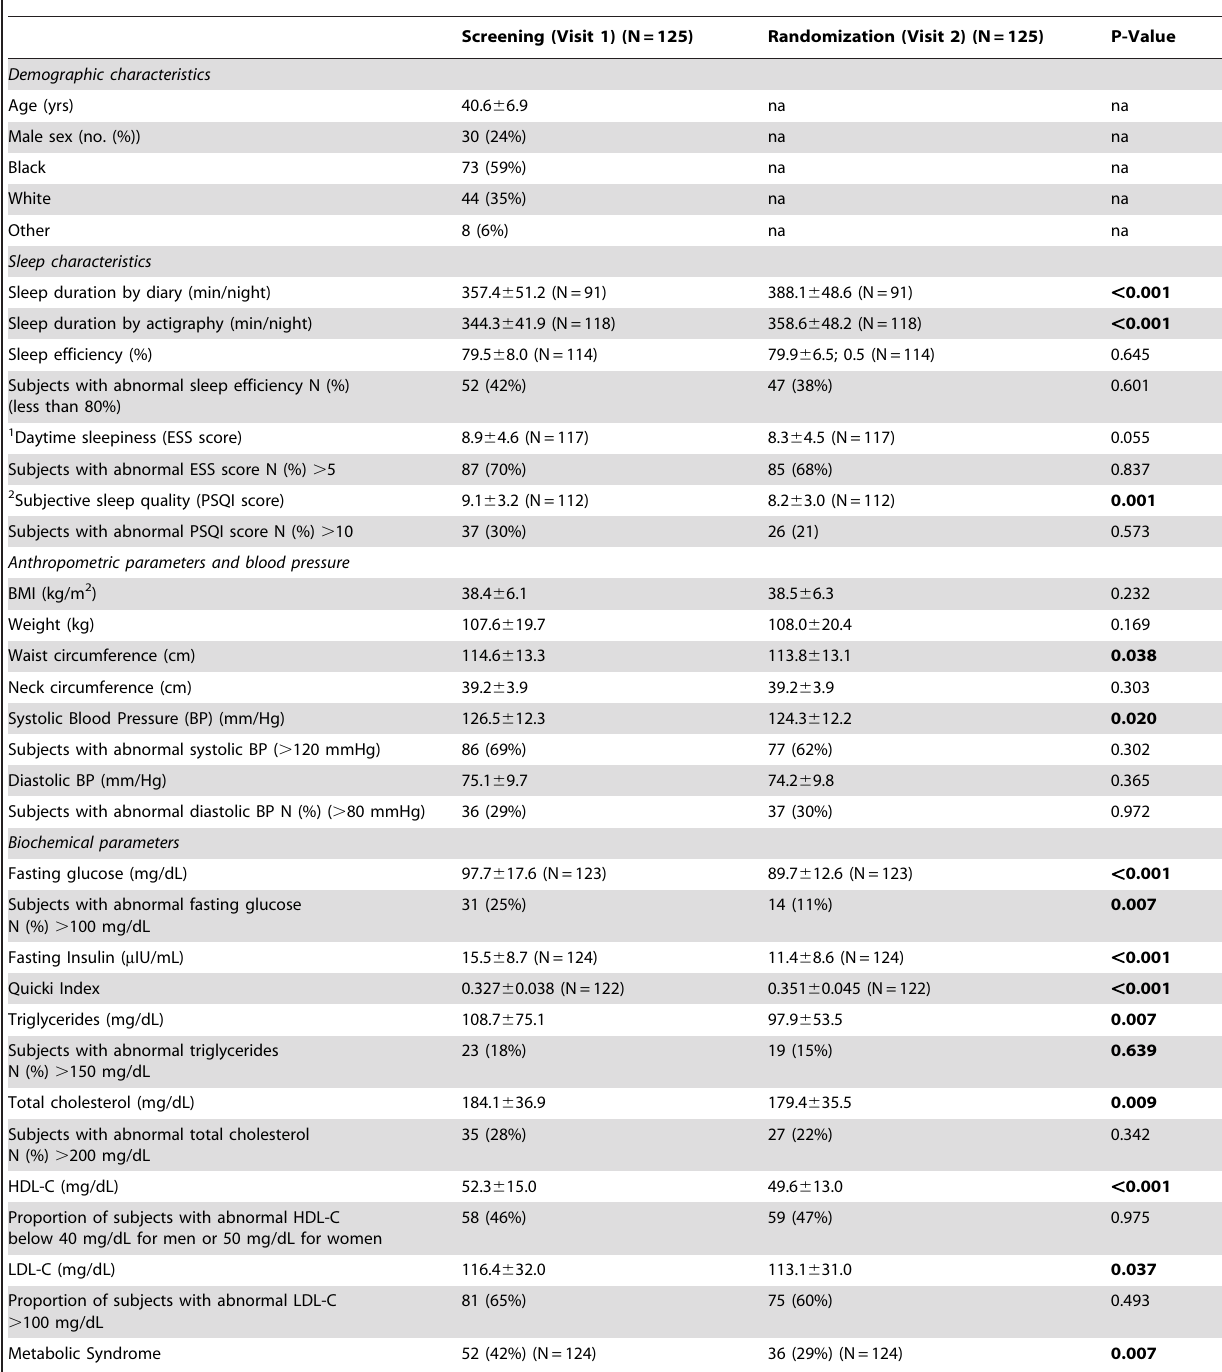
Table 1. Characteristics of Participants at Screening (Visit 1) and Randomization (Visit